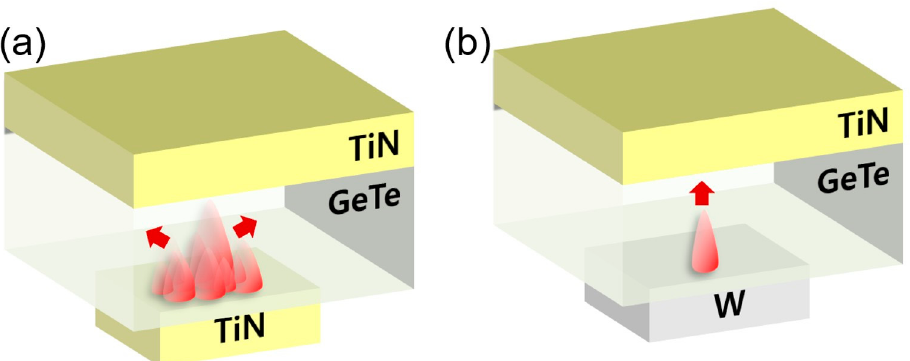
Figure 5. Schematics of the crystallization model suggested by considering JMA kinetics and simulation: ( a ) TGT (crystalline growth with multiple nuclei) and ( b ) TGW (crystalline growth with one nucleus).